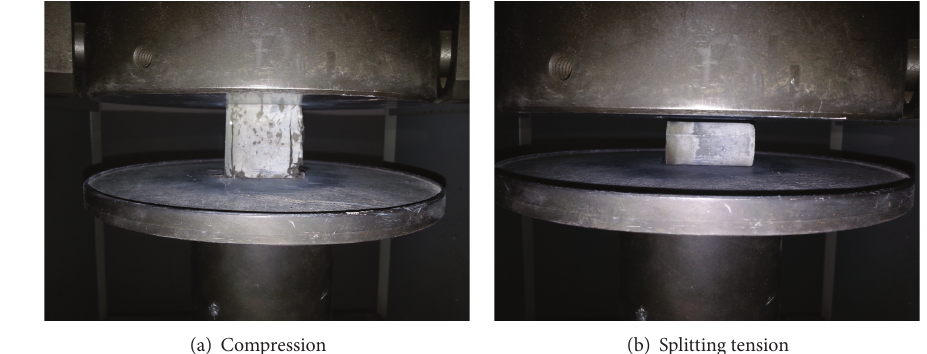
Figure 5: Test for compressive and splitting tensile strength.